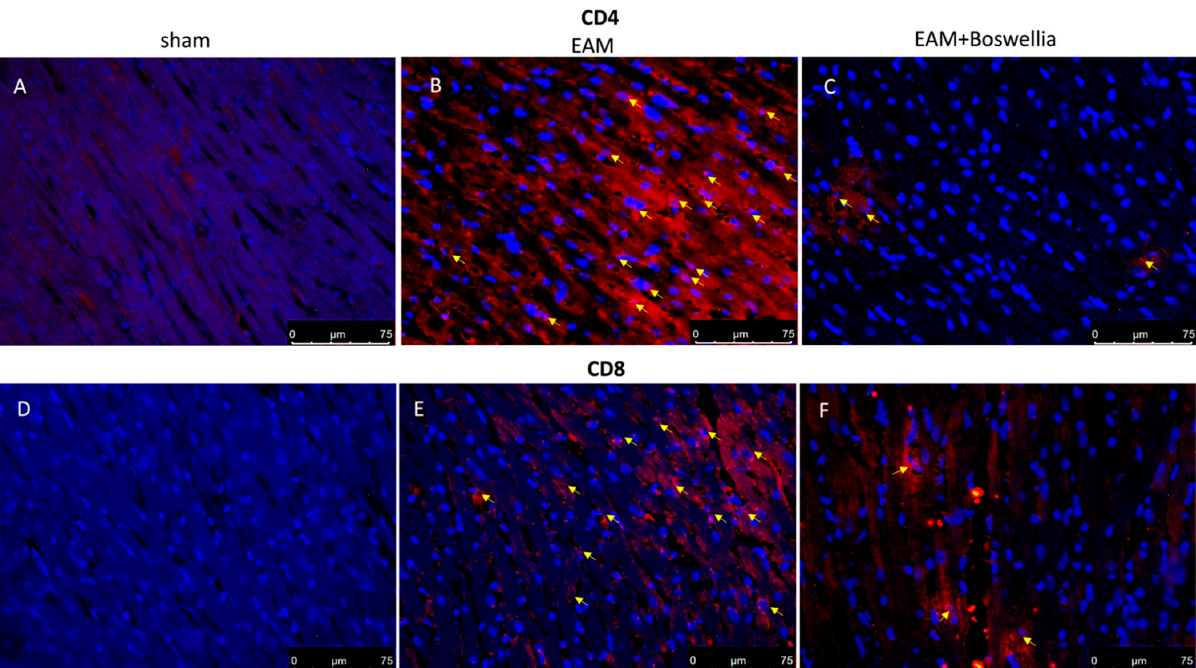
Figure 6. Effect of Boswellia extract on CD4 and CD8 expressions. Immunofluorescence for CD4 and CD8 (red) (see yellow arrows) in heart sections of sham animals ( A , D ), EAM + vehicle ( B , E ) and EAM + Boswellia gum extract ( C , F ). Boswellia extract administration was able to reduce CD4 and CD8 expressions.. Scale bar: 75 μ m. Magnification (40×).